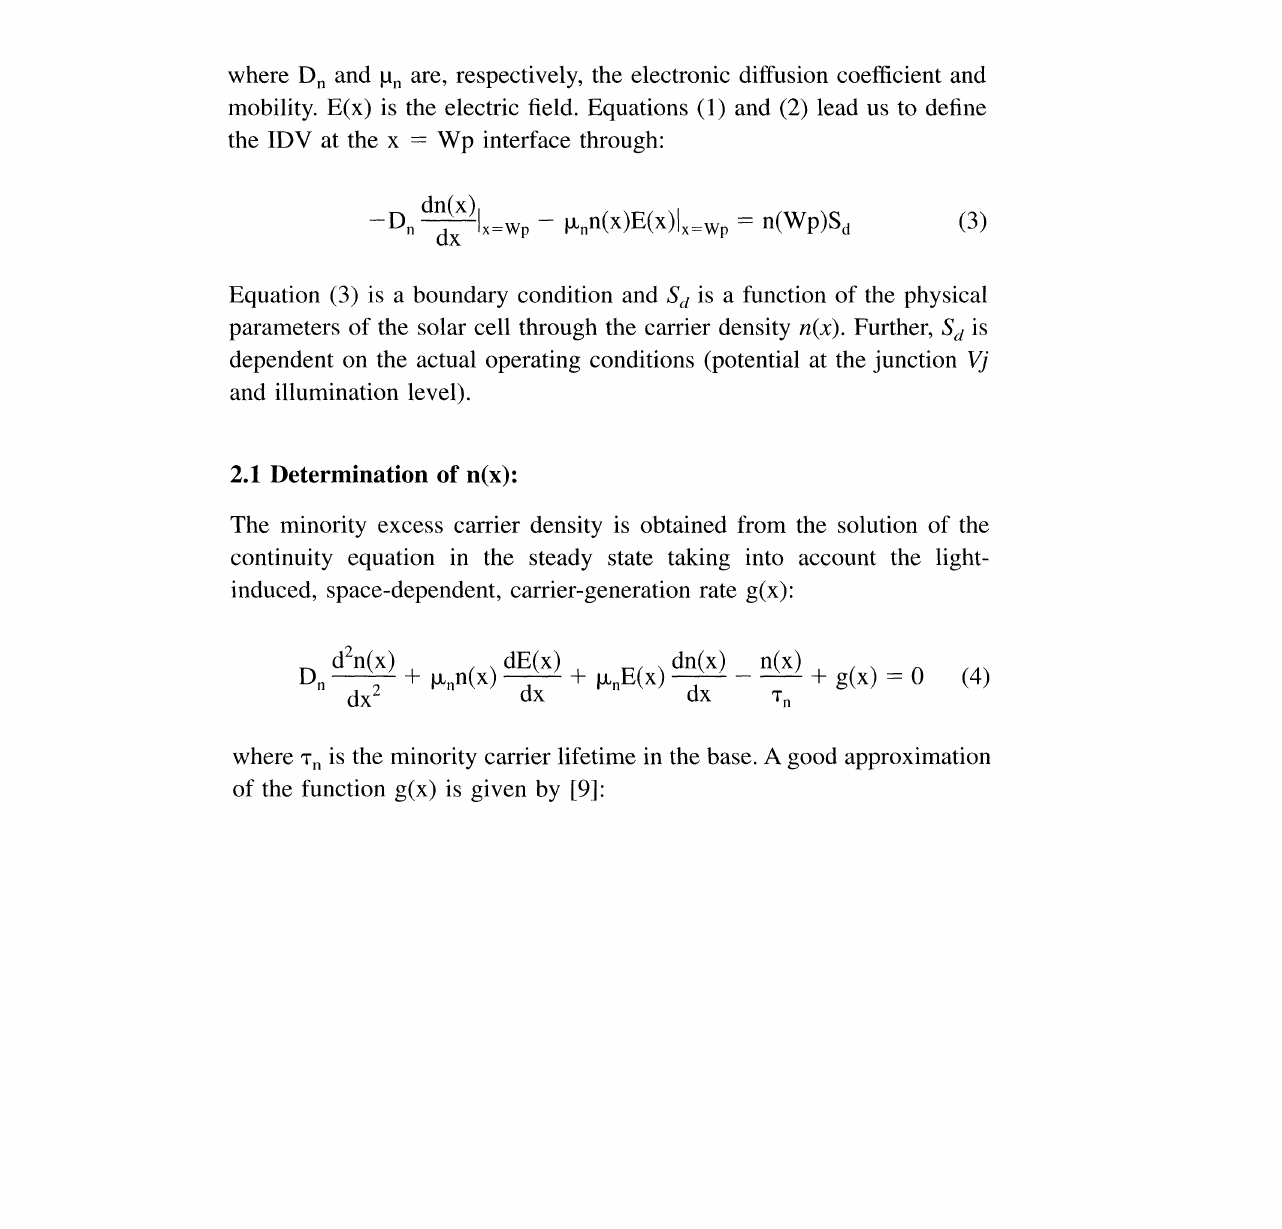
FIGURE Schematic structure of n +-p solar cell for present